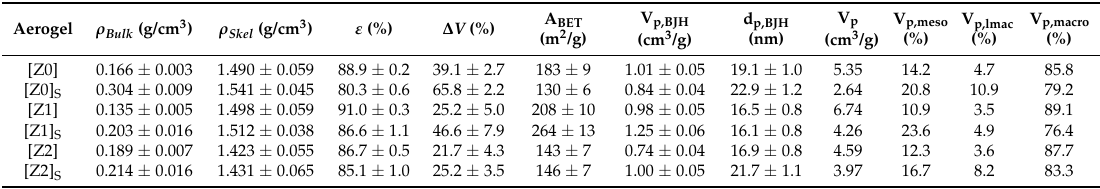
Table 1. Morphological and textural properties of starch-based aerogels processed using different zein porogen contents. Notation: [Z0] = Starch aerogels; [Z1] = Starch aerogels gelified in a 1:2 zein-to-starch weight ratio; and [Z2] = Starch aerogels gelified in a 1:1 zein-to-starch weight ratio. Subscript “S” denotes sterile aerogels obtained by scCO 2 treatment.